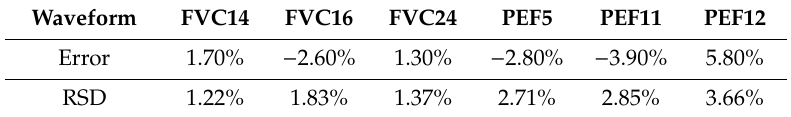
Figure 9. The resulting curves (the black curves) of three FVC and three PEF waveform tests using the developed spirometer and the standard ones (the red curves). Table 1. The accuracy and reliability of the developed spirometer in pulmonary function tests.